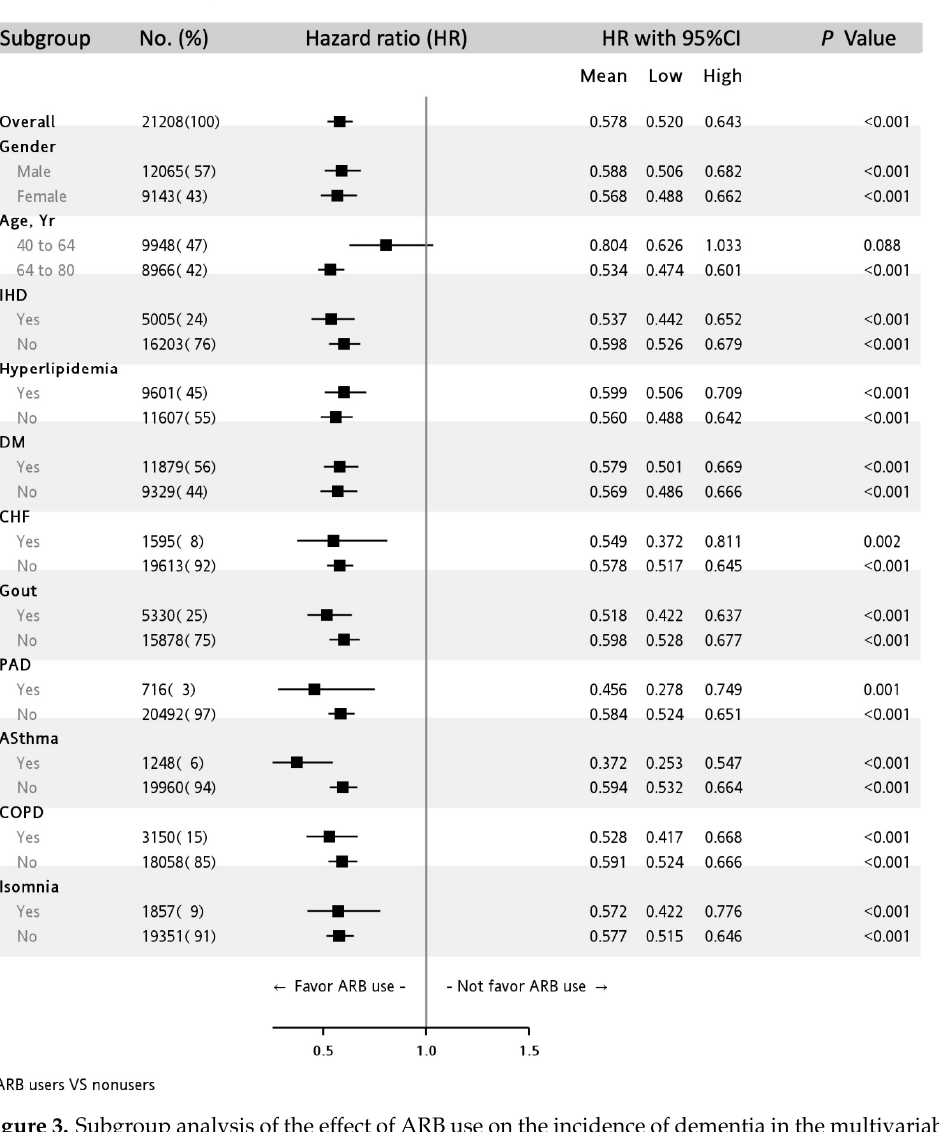
Figure 3. Subgroup analysis of the effect of ARB use on the incidence of dementia in the multivariable adjusting model.